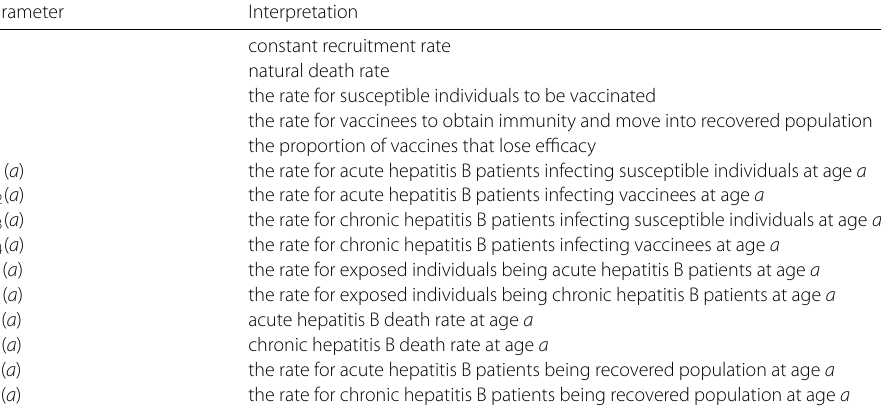
Table 1 Parameters and their biological meaning in model